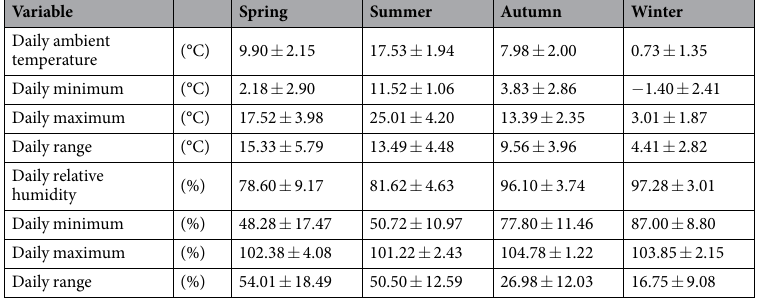
Table 1. Ambient temperature and relative humidity during two weeks at four different seasons (spring, summer, autumn and winter, see text for details) under central European climatic conditions. Values are means ± sd.